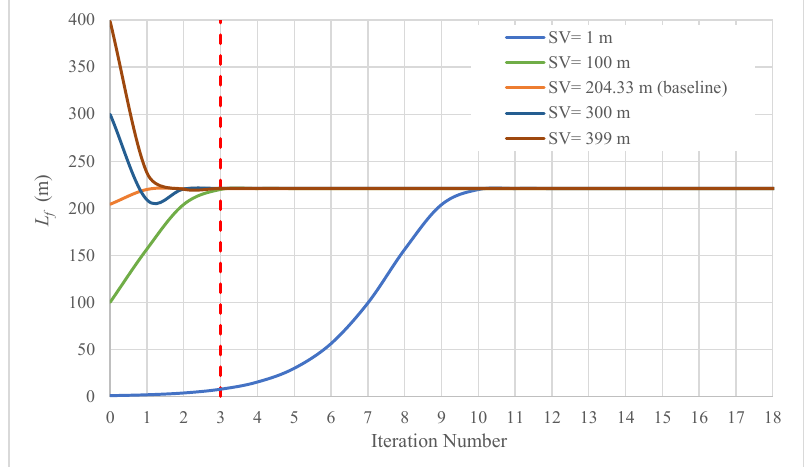
Figure 10. Sensitivity analysis of iteration number using the Newton–Raphson method.